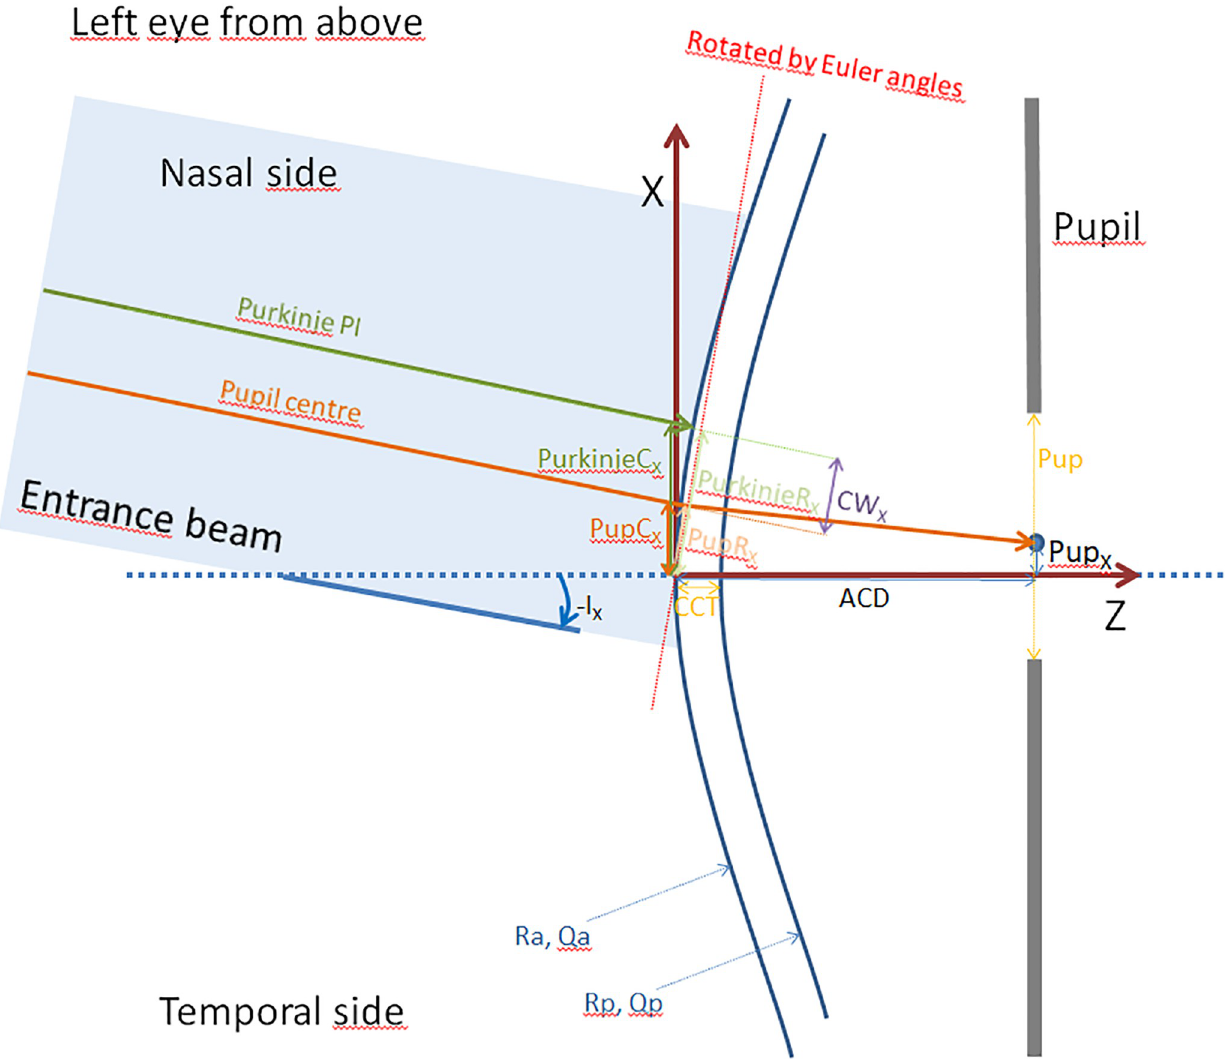
Fig 1. Schematic drawing of a left eye from above (the vertical coordinates are not shown in the plot). The corneal front and back surface (with radius of curvature Ra and Rp and asphericity Qa and Qp respectively) are coaxially aligned with the Z axis of the coordinate system . The incident ray is tilted by angle I X (negative values for I X as the ray is tilted to nasally). The location of the pupil centre (Pup X ) is used to calculate the location of the pupil centre at the corneal apex plane (PupC X ). PurkinjeC X refers to the projection of the Purkinje image PI at the corneal apex plane. Coordinates PurkinjeC X and PupC X are rotated to a plane perpendicular to the entrance beam ro read out the coordinates PurkinjeR X and PupR X as determined by the tomographer. The Chang Waring chord CW X is derived from the coordinate points of PurkinjeR X and PupR X . CCT / ACD / Pup refer to the central corneal thickness / the anterior chamber depth as the distance from the anterior corneal apex to the front apex of the crystalline lens / the pupil size as measured with the Casia 2 tomographer.